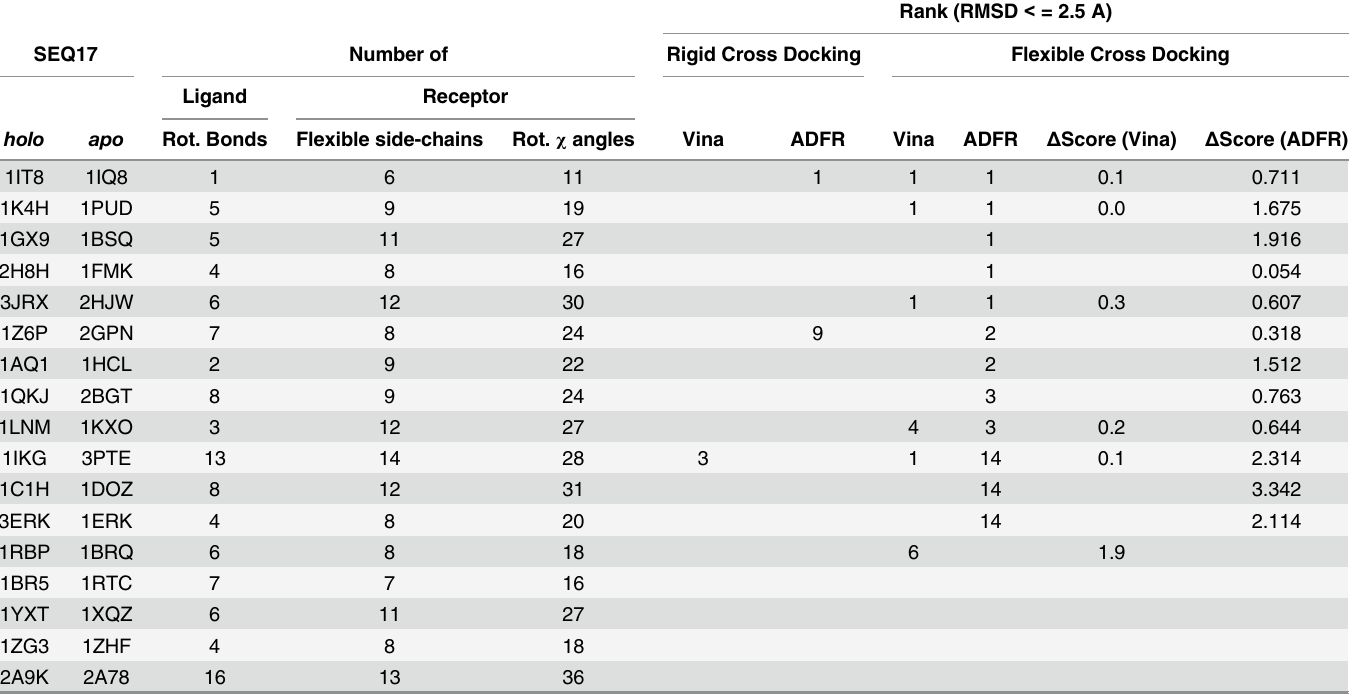
Table 1. SEQ17 cross-docking into apo conformations with receptor side-chains.